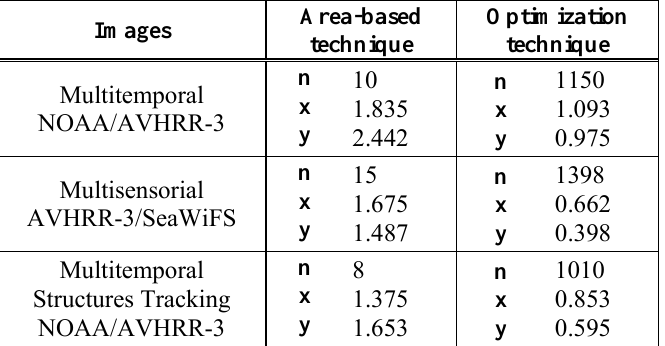
Table 3. Comparison between an area-based technique and the optimization technique